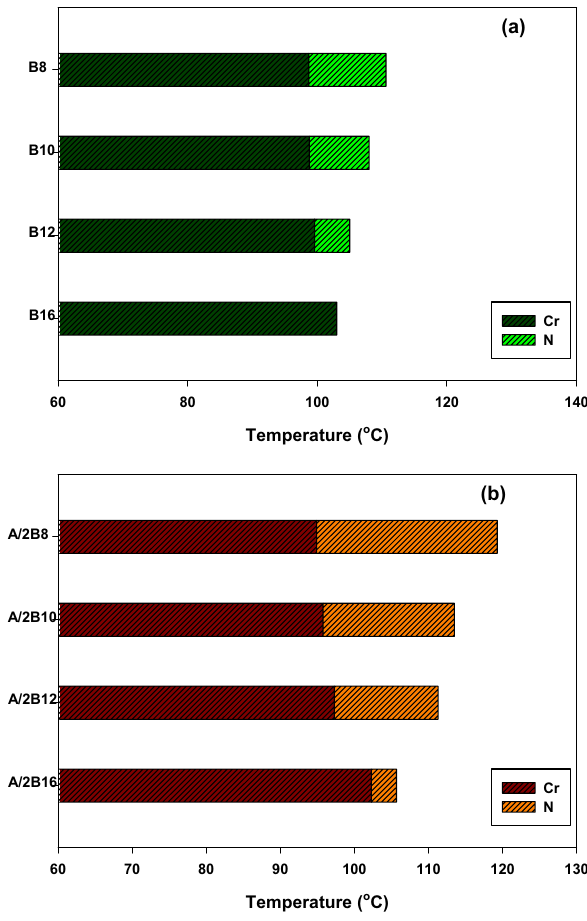
Figure 4. Graphical DSC transitions of ( a ) azopyridine homologues series ( Bn ) and ( b ) their supramolecular H-bonded complexes A/2Bn from second heating cycle.